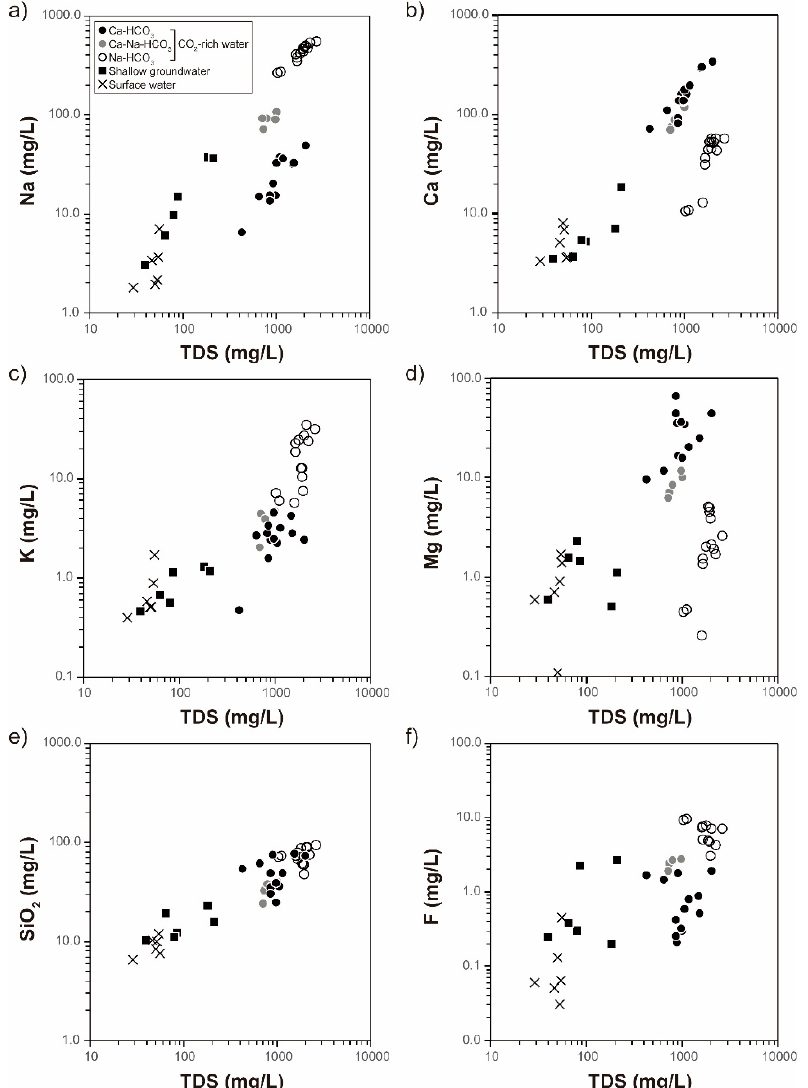
Figure 4. Plots of TDS versus major elements for water samples: ( a ) Na, ( b ) Ca, ( c ) K, ( d ) Mg, ( e ) SiO 2 and ( f ) F.